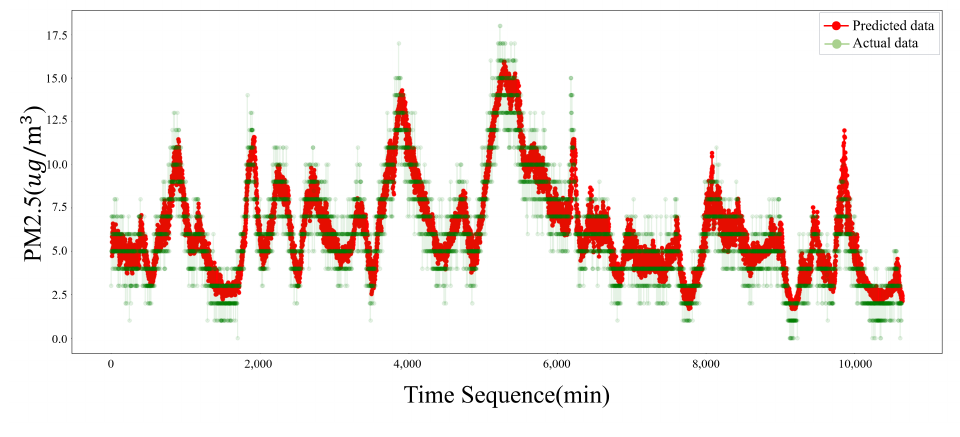
Figure 6. PM2.5 (indoor) prediction model.